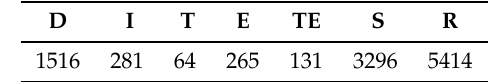
Table 2. The results in the 49 annotated Istex documents.